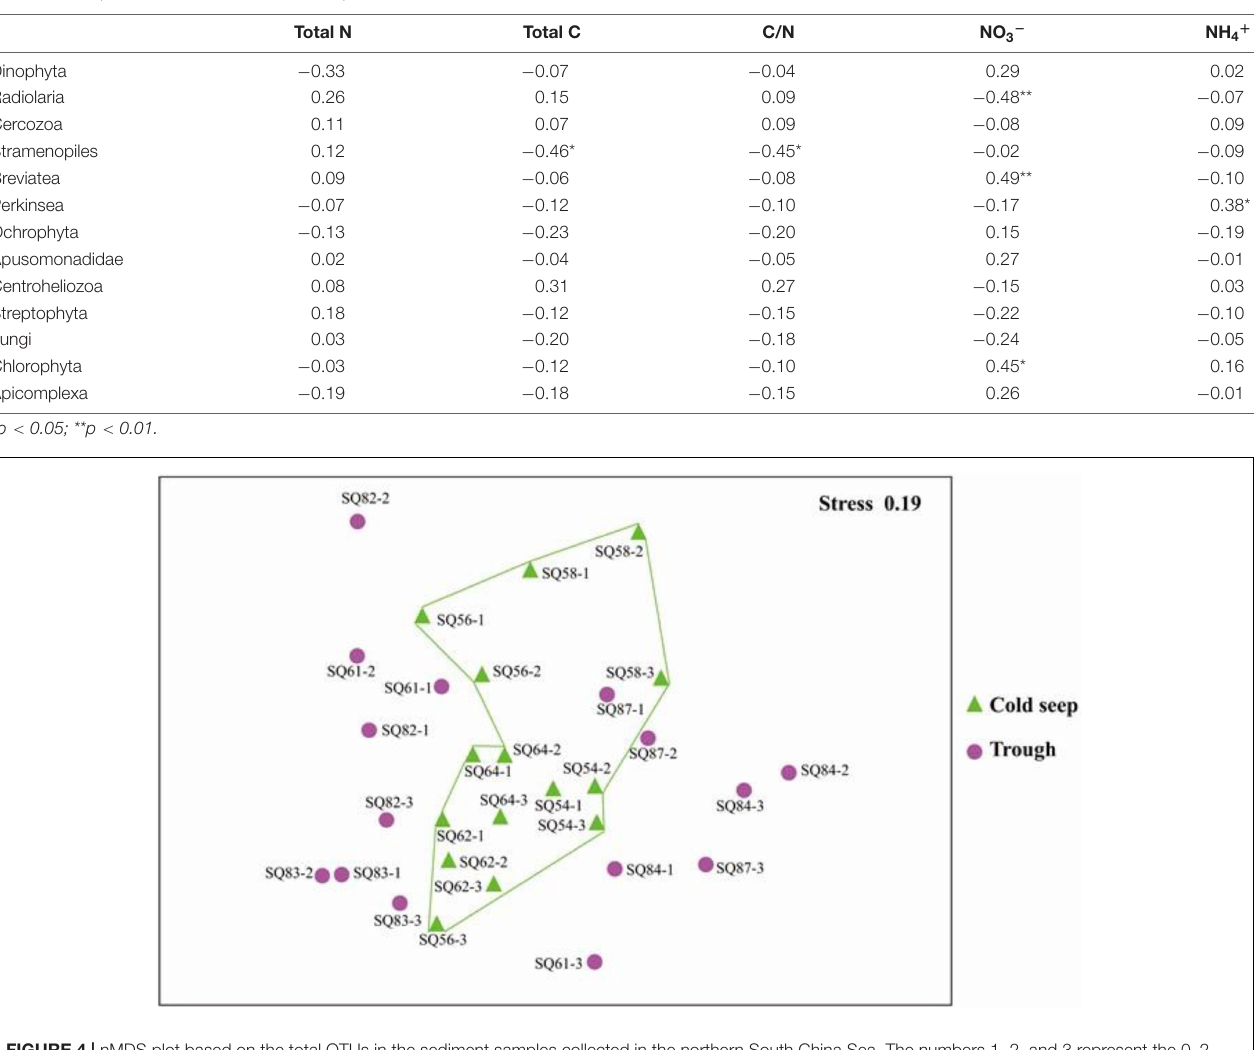
TABLE 2 | The Pearson correlation coefficients indicating the relationship between various microbial eukaryotes (with relative abundance > 2%), and different environmental parameters in the sediment samples collected from the northern South China